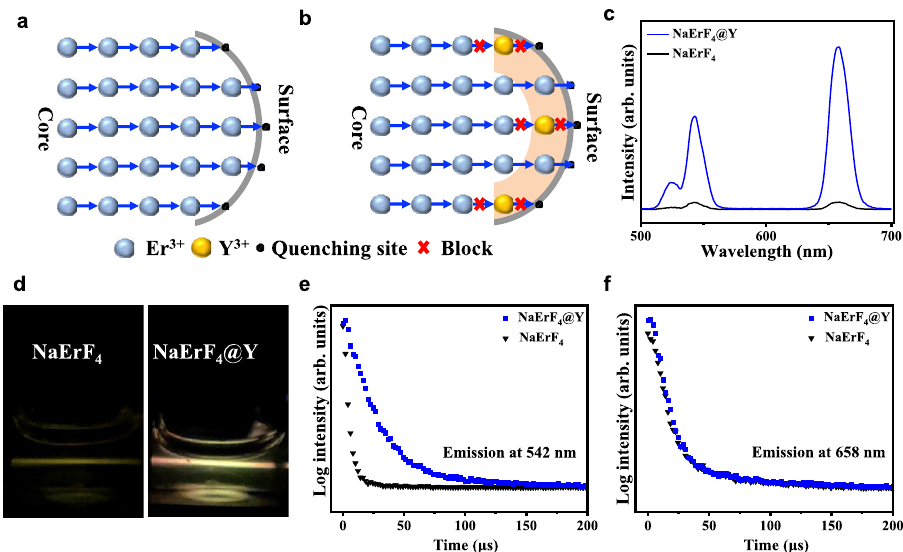
Fig. 4 Spectroscopic study of NaErF 4 before and after ion exchange. a Schematic diagram of luminescence quenching caused by energy transfer to the surface. The excitation energy would migrate among Er ions (blue) and travel to the quenching site (dark) on the surface. b Proposed mechanism of luminescence enhancement after ion exchange. The Y 3 + ions replaced some Er 3 + ions on the surface and created an effective shell region (shaded area) such that the energy migration to the surface quenching site was blocked. c , d Upconversion emission spectra and corresponding